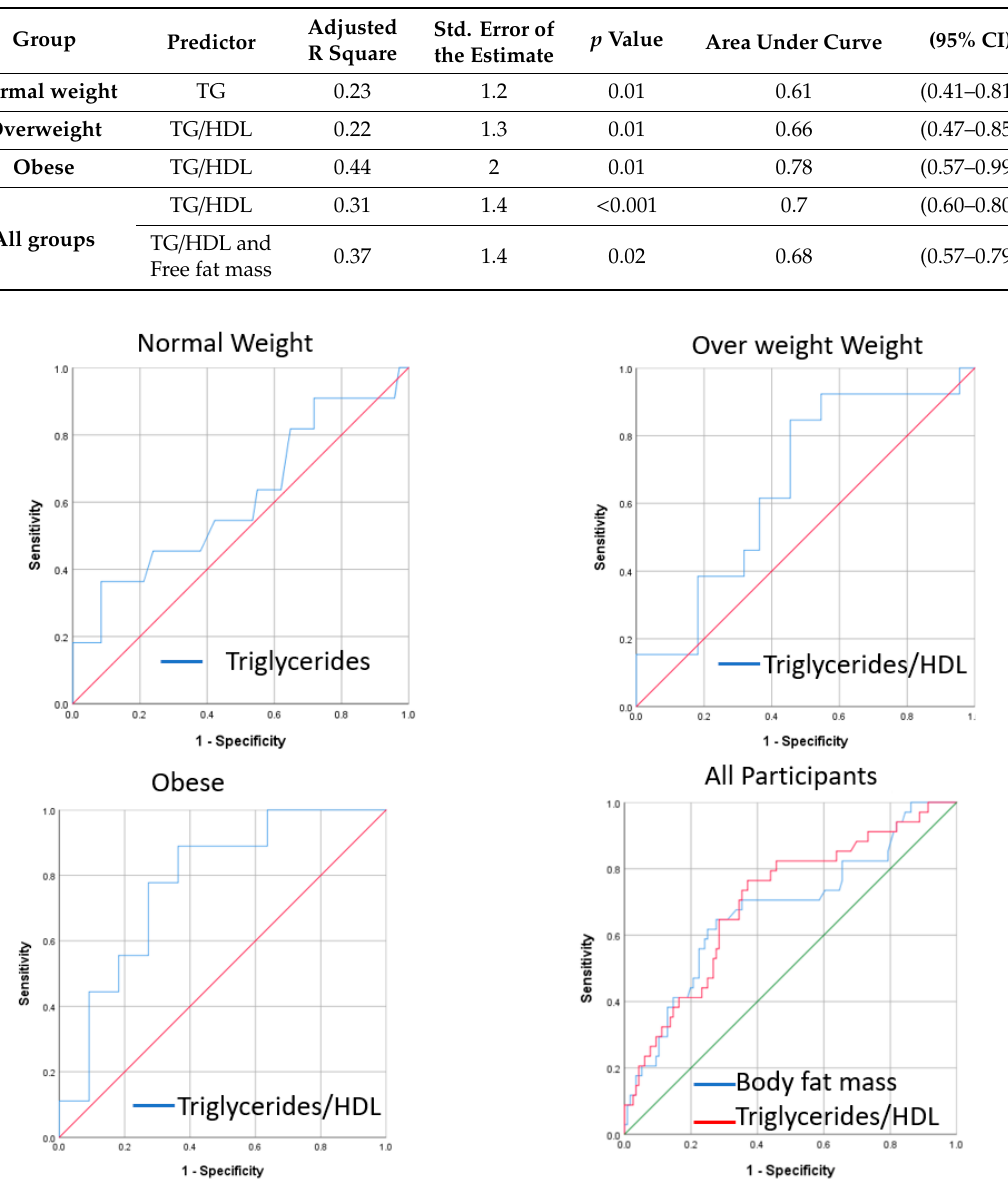
Figure 2. ROC curve for triglycerides, triglycerides / HDL and body fat mass as a predictor for the HOMA-IR index in normal, overweight / obese and all participants.